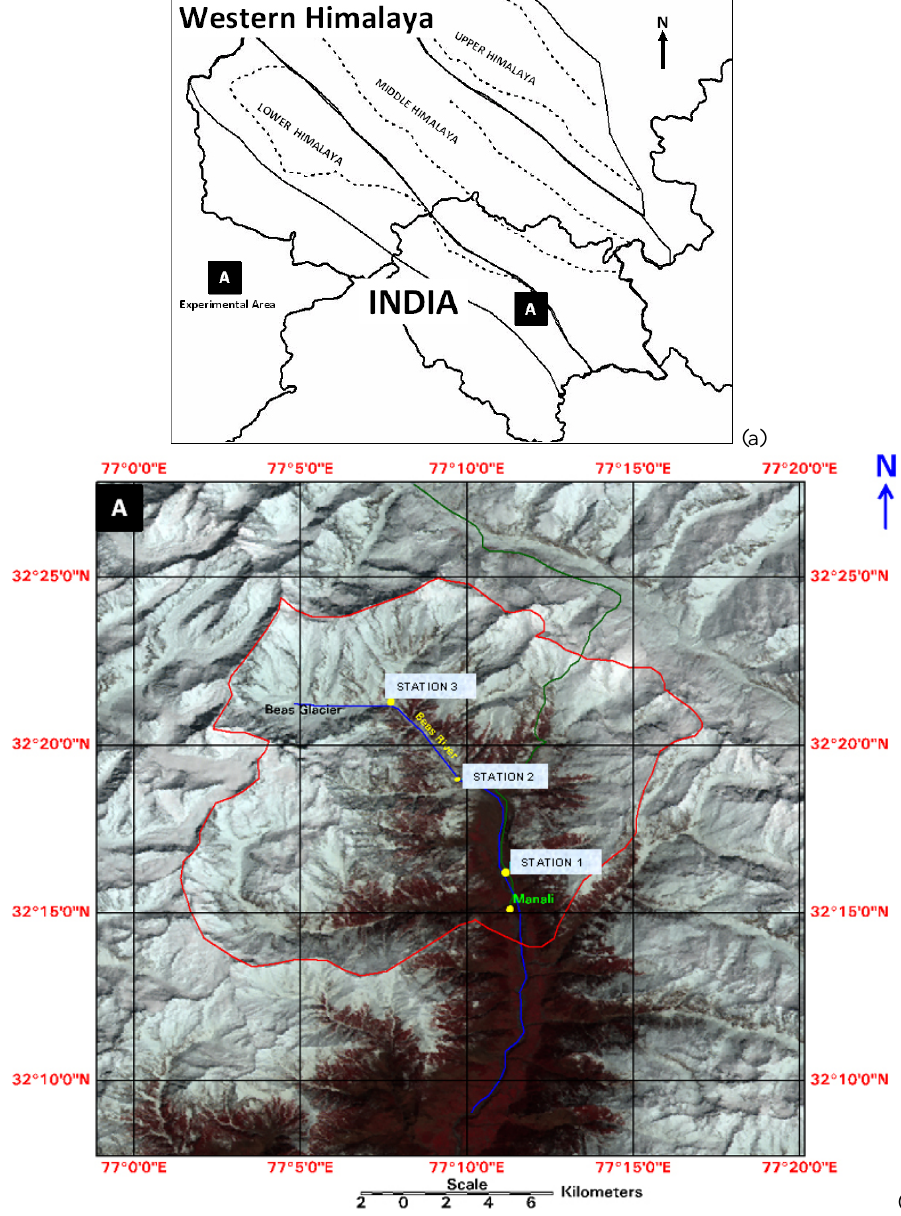
Fig. 1. (a) The map of the western Himalaya comprising three different zones based on the snow climatic conditions, (b) locations of field investigations carried out at station 1–3 in Beas basin of